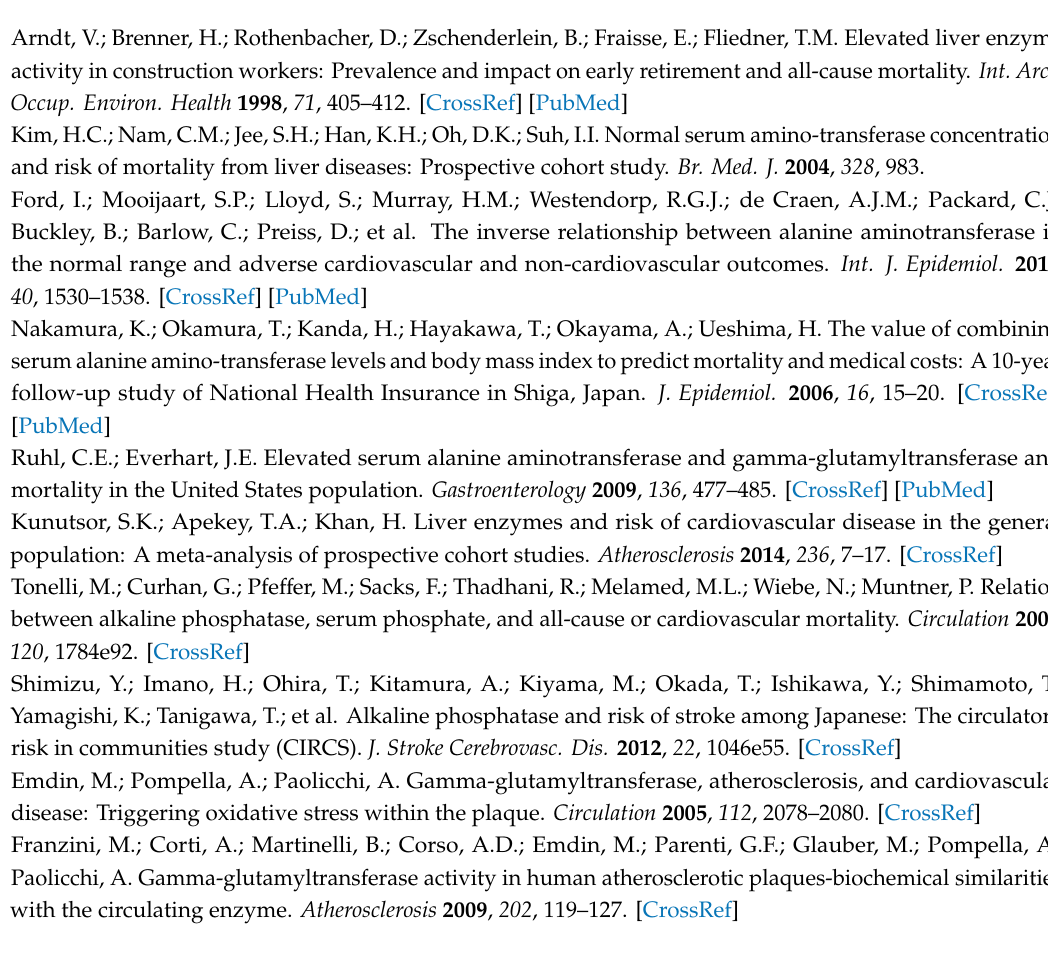
Table S1: Clinical Characteristics of Study Cohort, Table S2: Association of Serum ALT and AST with Long-Term Blood Pressure Variability in Participants Without Current Alcohol Intake in Multivariable Liner